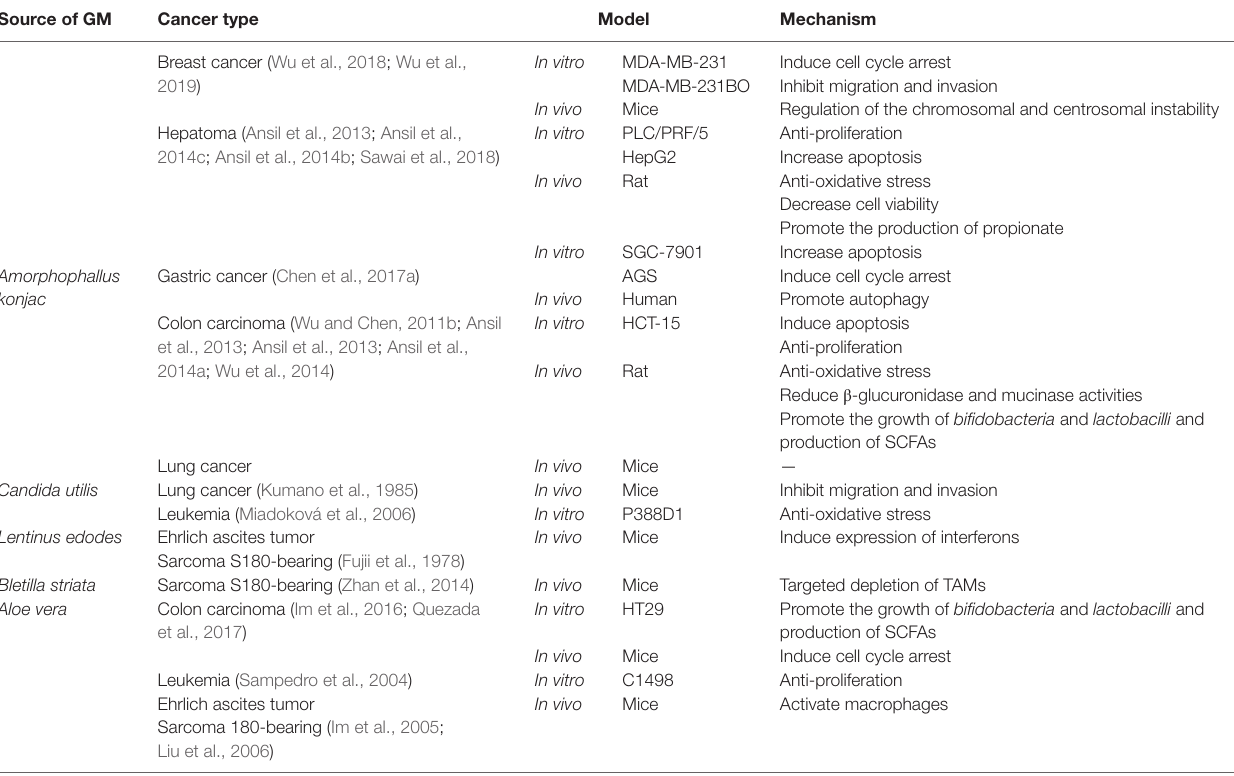
TABLE 1 | The anti-tumor mechanism of glucomannan in different cancer